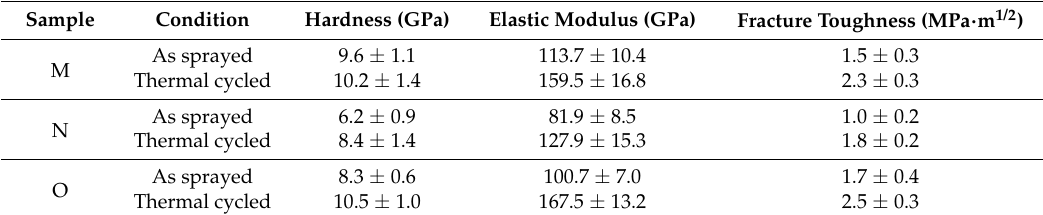
Table 3. Mechanical properties of as-sprayed and thermally-cycled Samples K, L, and M.